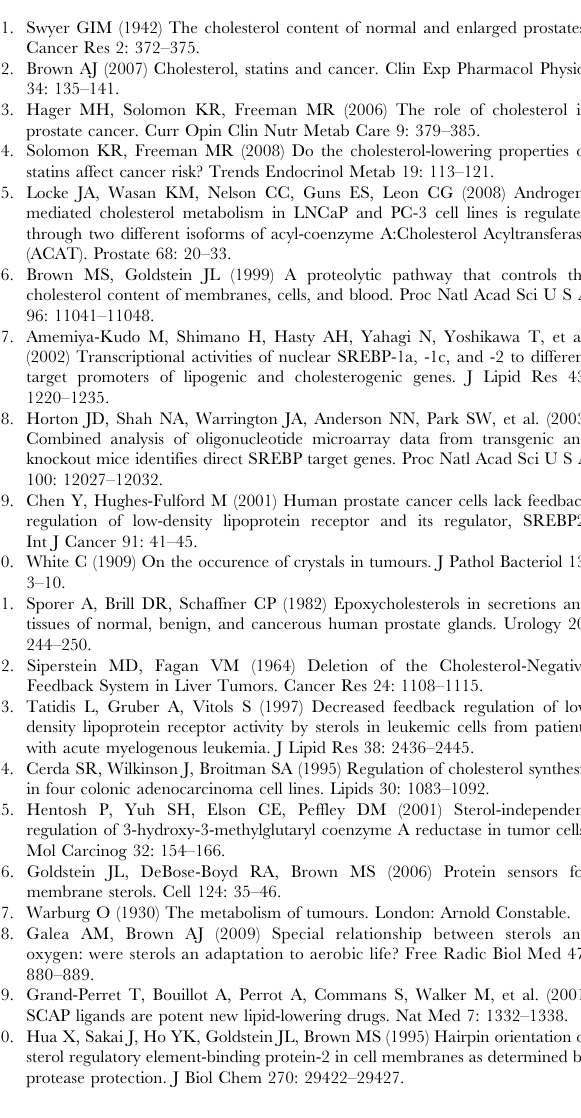
Figure S2 Sterol-mediated regulation of SREBP-2 target